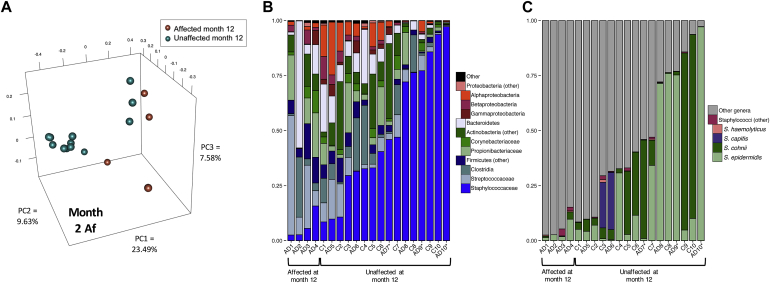
Af microbial community differences predate AD presentation. A, Month 2 Af samples were examined by using principal coordinates analysis of the theta similarity coefficient. Samples were clustered by those that went on to be affected at month 12 and those that were unaffected at month 12 (P = .003, AMOVA). B, Relative abundance of major taxa. Subjects who went on to be affected at month 12 had significantly lower proportions of Staphylococcus species than those who went on to be unaffected (P = .008, Wilcoxon rank sum test). C, Relative abundance of staphylococcal species. S aureus was essentially absent in these communities. PC, Principal component.